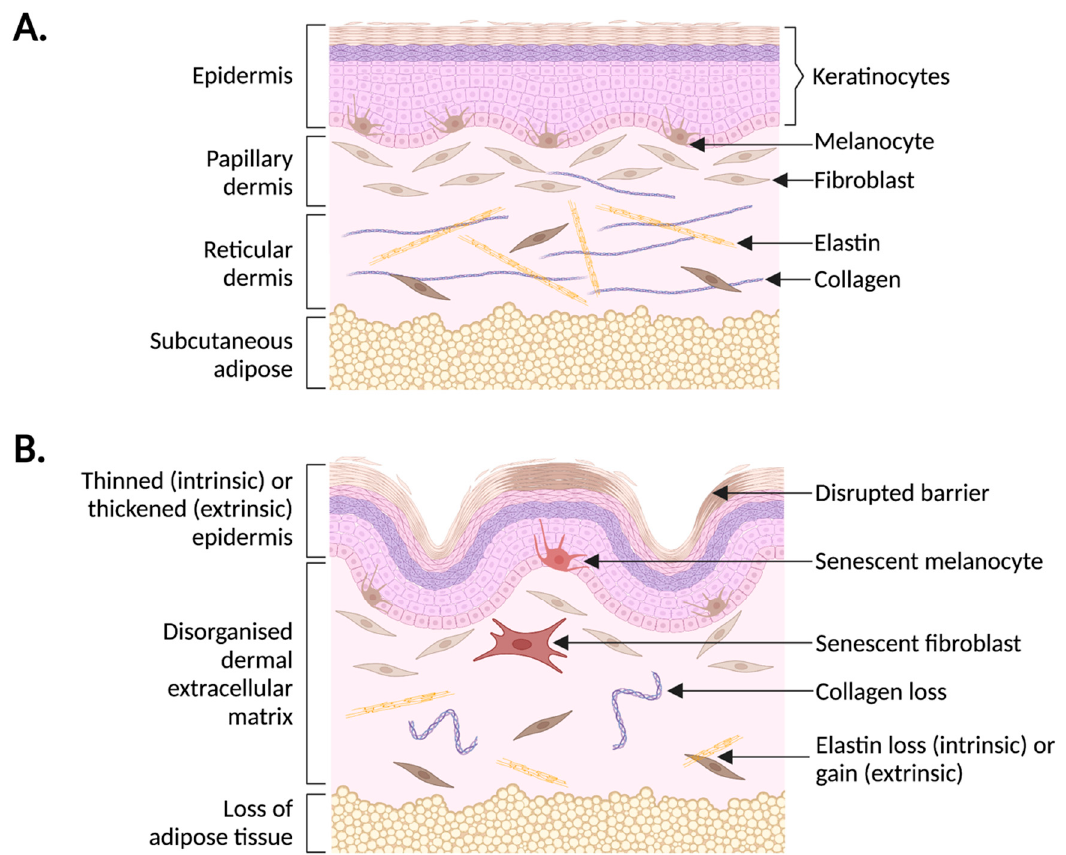
Figure 2. The structure of young versus old skin. ( A ) Human skin is divided into an epidermis, dermis, and subcutaneous adipose tissue. The epidermis contains stratified layers of keratinocytes, and melanocytes within the basal layer. The dermis is further divided into a fibroblast-rich papillary layer, and an ECM-rich reticular layer containing collagens and elastin. ( B ) With age, the epidermis may become thinner (intrinsic ageing) or thicker (extrinsic ageing), the stratum corneum barrier becomes dysfunctional, and there is the presence of senescent melanocytes within the basal layer.